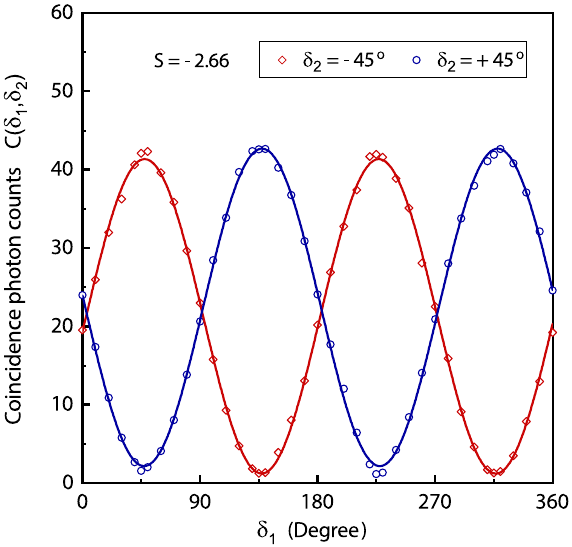
(cid:31) − at different orientations of pass axes of | � p δ 2 ) corresponding to the coincidence detection −